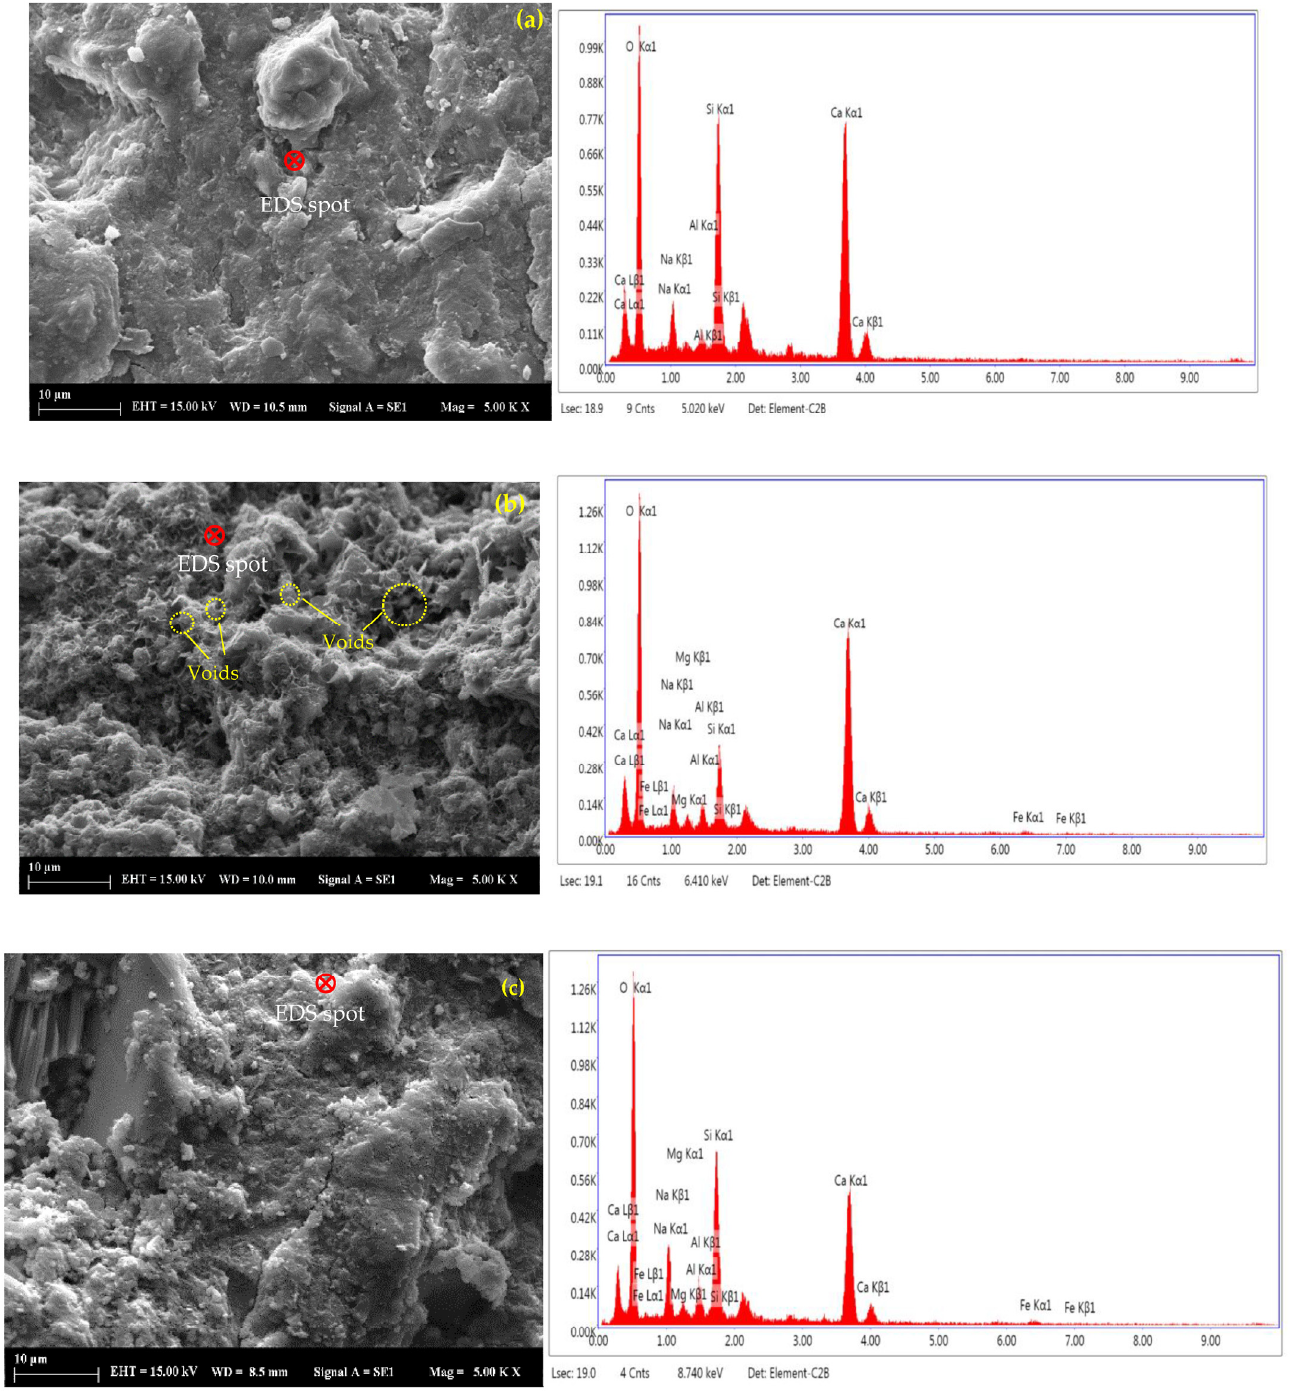
Figure 9. SEM-EDS of alkali-activated pastes: ( a ) B0.2-6, ( b ) B0.6-2, and ( c ) B0.6-6.